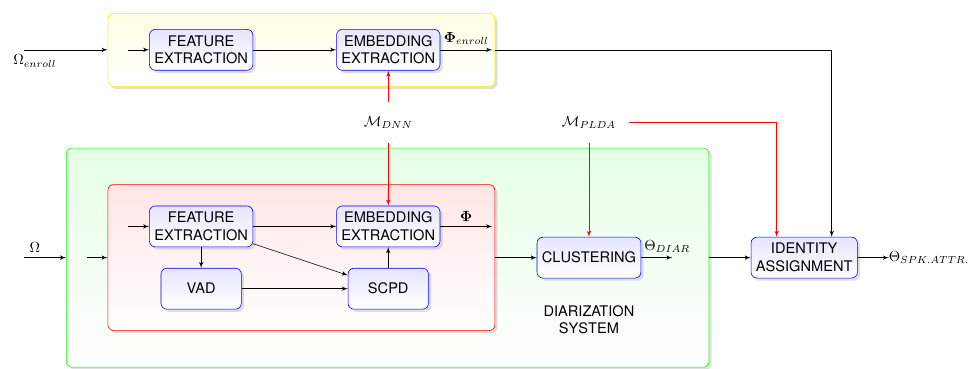
Figure 6. Flowchart of the indirect assignment approach. Red and yellow boxes, respectively, stand for embedding extraction pipelines for the evaluation audio Ω (online) and enrollment audios Ω enroll . The green box means a diarization system, which clusters the evaluation embeddings Φ to obtain diarization labels Θ DIAR . The obtained embeddings ( Φ and Φ enroll ) as well as the estimated labels Θ DIAR are taken into account in the identity assignment